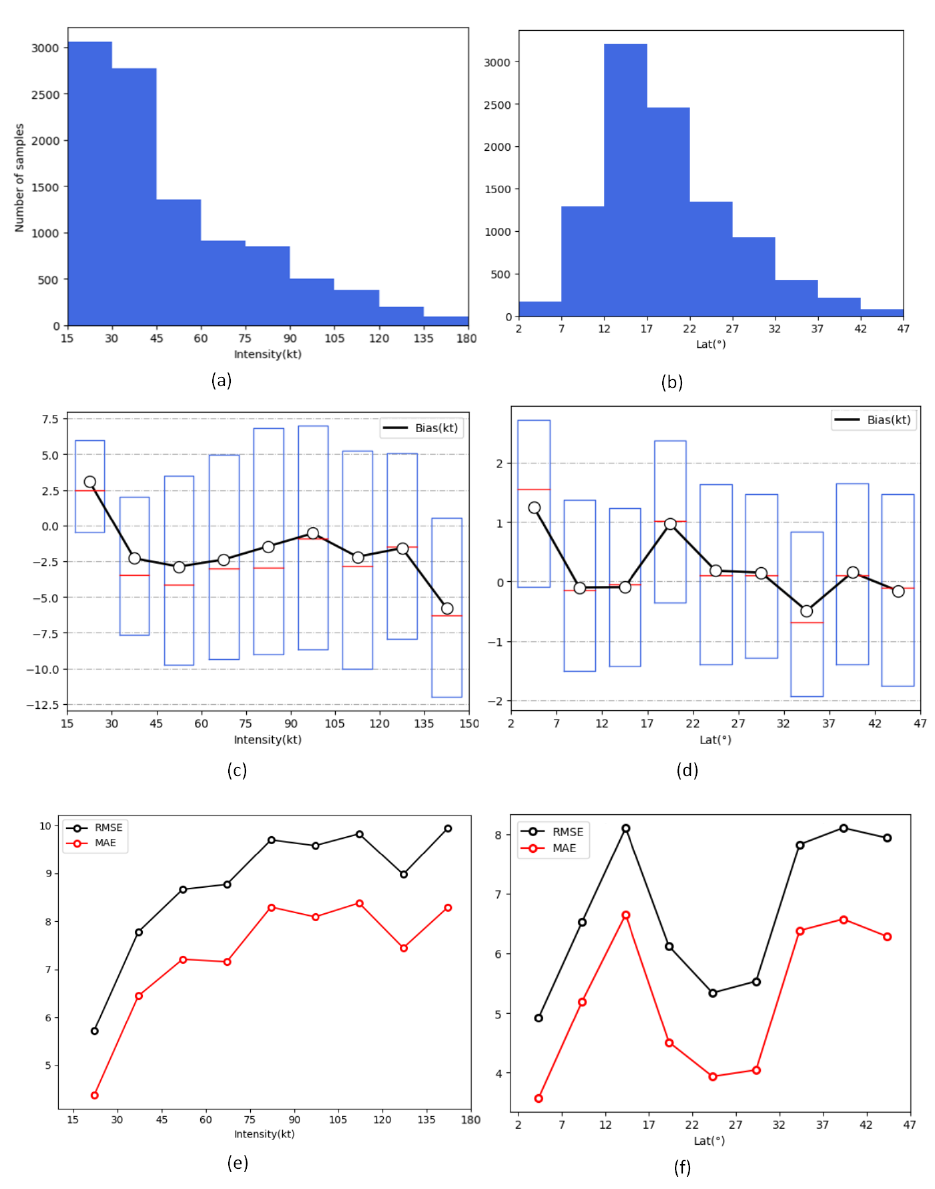
Figure 7. ( a ) Sample size at 15 kt intervals; ( c ) box plots at 15 kt intervals, and ( e ) RMSE and MAE of TCICVIT at 15 kt intervals. ( b ) Sample size at 5° latitude intervals, ( d ) box plots at 5° latitude intervals, and ( f ) RMSE and MAE of TCICVIT at 5° latitude